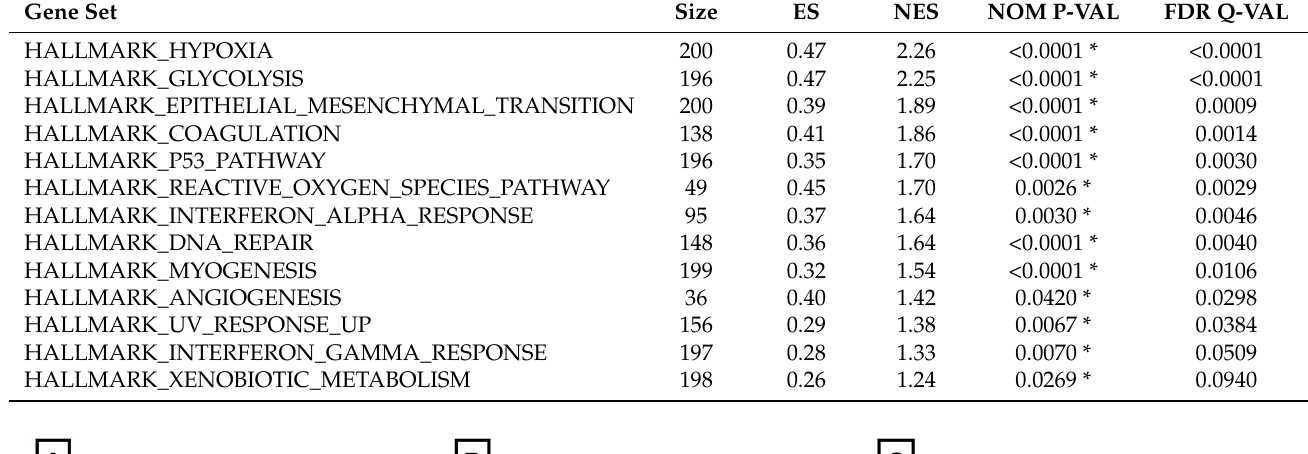
Table 2. Characteristics of 13 significantly upregulated gene sets based on the NNU panel. Sig- nificance criteria comprise a p -value < 0.05 and a false discovery rate (FDR) < 0.25. ES = enrich- ment score, NES = normalised enrichment score, NOM P-VAL = normalised p -value, and FDR Q-VAL = false discovery rate q-value. * indicates significant p -values.